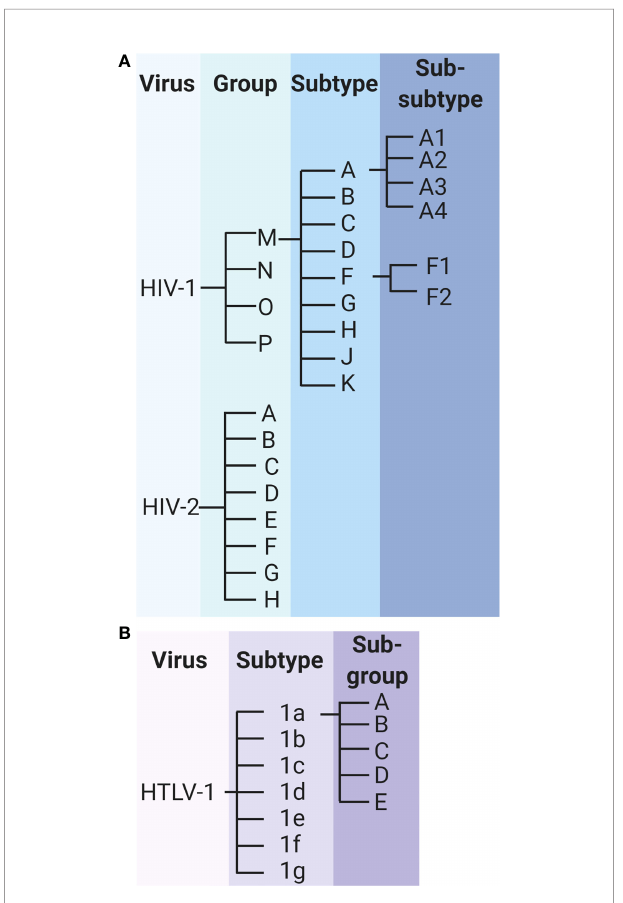
FIGURE 4 | Classi fi cation of HIV-1, HIV-2 and HTLV-1. (A) Classi fi cation of HIV-1 and HIV-2 groups, subtypes, and sub-subtypes. (B) Classi fi cation of HTLV-1 subtypes and